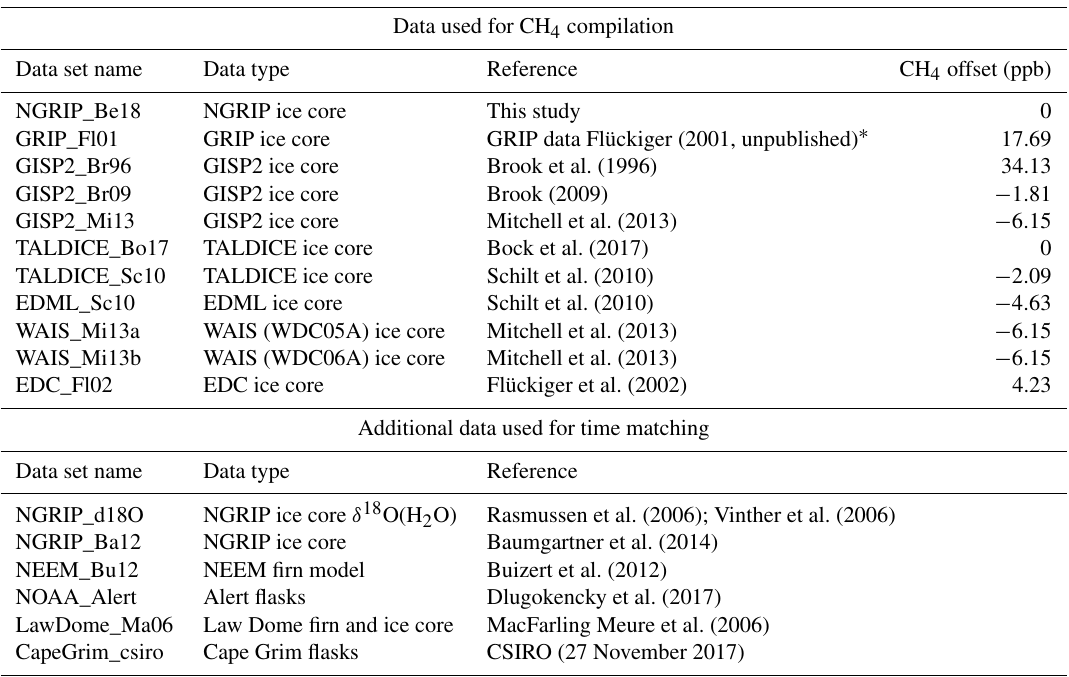
Table 1. Data sets used for CH 4 data compilation. The CH 4 offset correction is added to the data to correct for inter-laboratory and time- period-related offsets (see Sect. 2.3.2). Additional data sets used for the time matching (e.g. covering the rapid CH 4 increase after 1850CE or the Younger Dryas–Holocene transition) are